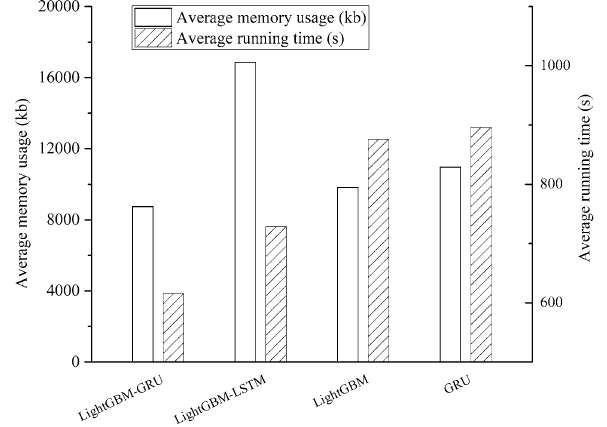
Figure 8. Performance comparison.